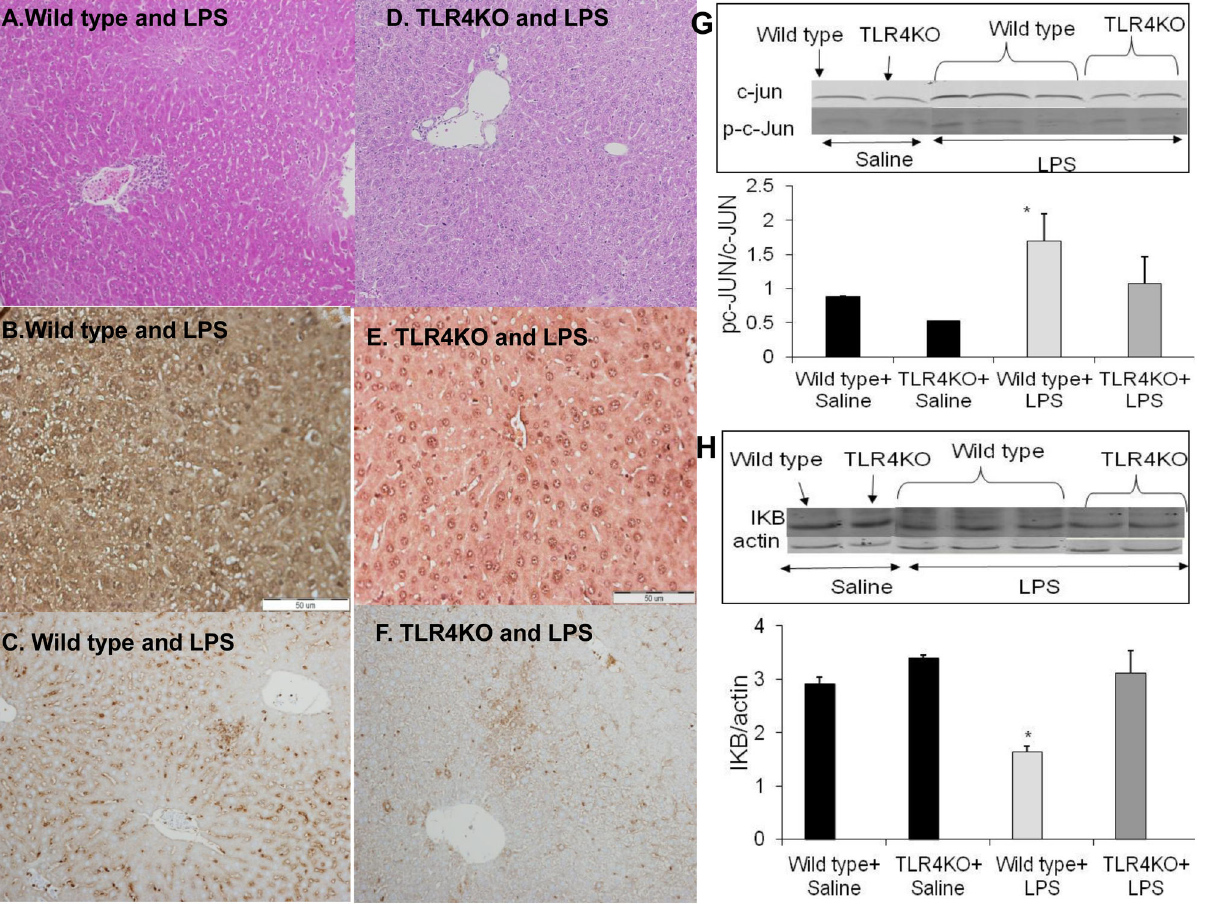
Figure 3. A, D: Histological staining using H&E. The inflammatory hepatic damage following LPS-administration in WT mice (A) compared to TLR4KO mice (D) was notably higher. B, E: TLR4 protein immune staining in LPS treated mice: TLR4 protein expression was upregulated at 4 hours (B) in WT mice compared to (E) no TLR4 immuno staining in TLR4KO. C, F: MPO activity: An enzyme specific for neutrophils in WT and in TLR4KO livers was examined. A significant increase in hepatic MPO activity was observed in LPS administered WT mice. In LPS administered TLR4KO mice, a slight increase in hepatic MPO activity was observed compared to WT liver. G,H: Protein expression of phosphorylated c-JUN and IkB: The hepatic expression of phosphorylated c- JUN was significantly higher in LPS administered WT mice compared with saline administered mice using Western blot, p<0.05. LPS administration increased c-Jun activity in WT mice compared to LPS treated TLR4KO mice, p<0.05 (G). The activation of the NFkB signaling pathway was higher in LPS administered WT compared to TLR4KO mice (H). IkB hepatic expression was significantly lower compared with saline administered mice, (p<0.05). In LPS administered TLR4KO mice there were no significant differences in the IkB hepatic expression between the LPS administered and the non LPS administered mice. Values are mean ±SEM (n=6 mice per